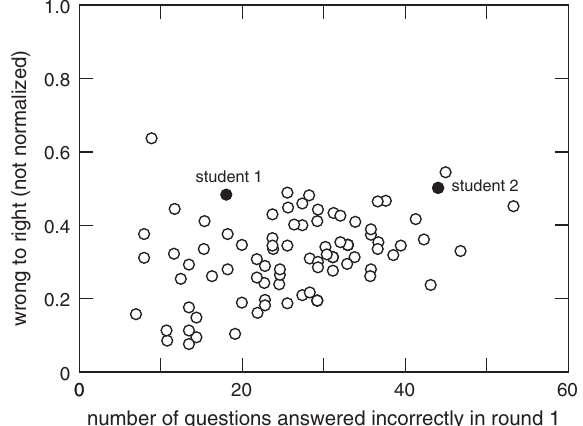
FIG. 2. Fraction of all CT responses that each student switches from wrong to right plotted as a function of the number of questions the student answers incorrectly in round 1. Students 1 and 2 both switch approximately 50% of the questions they answer from wrong to right. These two students are not directly comparable, however, because student 1 has far fewer incorrect answers in round 1 than student 2. Normalizing with respect to the number of incorrect answers in round 1 allows us to compare these two students.